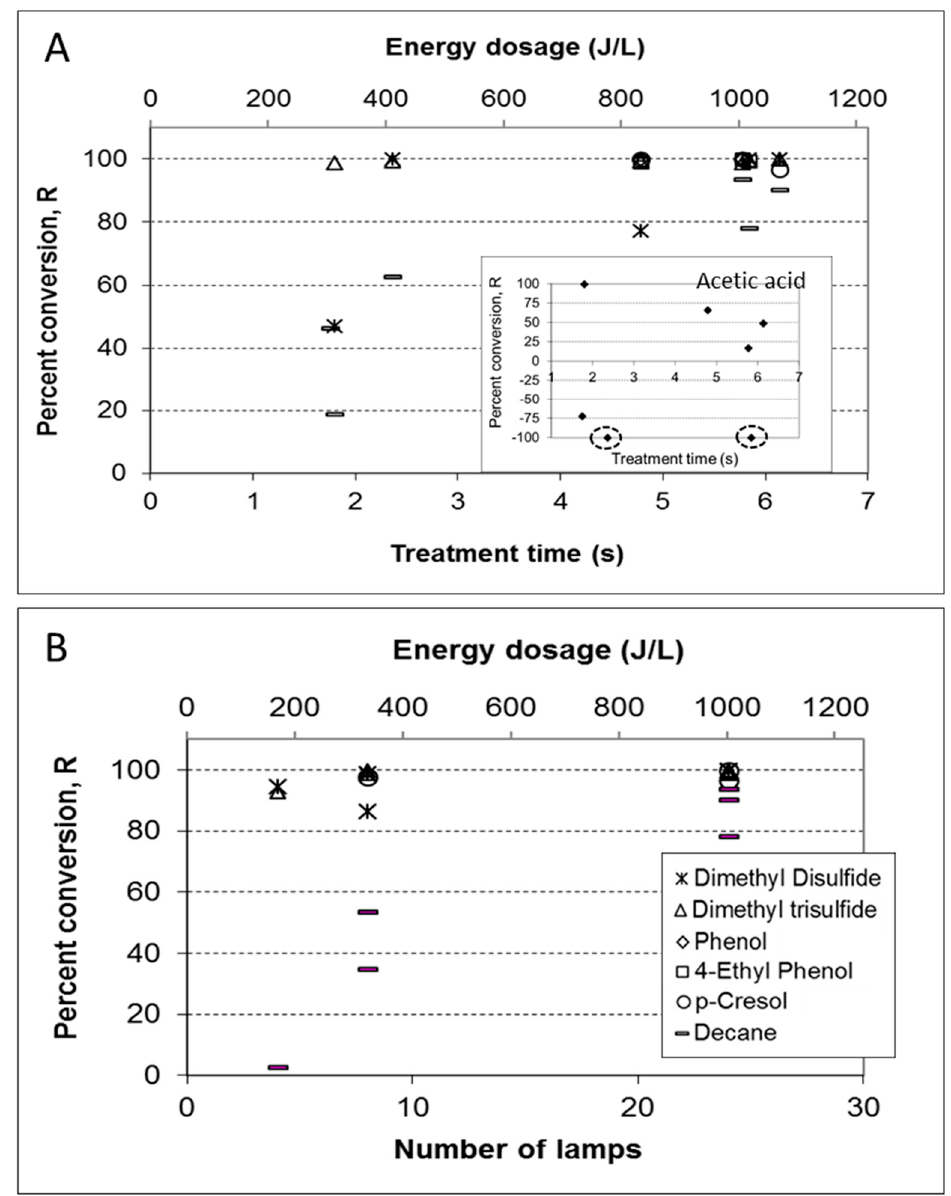
Figure 5. The effect of light energy dosage on VOC conversion rates ( A ) varying treatment time (s); ( B ) varying light intensity (number of UV lamps in use). Percent reduction represents the reduction in chromatographic peak area obtained by SPME-GC–MS (gas sampling time: 30 min). If peaks reduced below detection, they were considered as 1000 area counts for reduction calculations. For acetic acid (A; inset), data points in circles are for nondetected values before treatment (i.e., the peak area of 1000) and peak areas two orders of magnitudes larger after treatment ( R is out of scale). Light energy dosage was calculated from the actual irradiation received by the reactor per lamp and ca. 35% lamp efficiency.